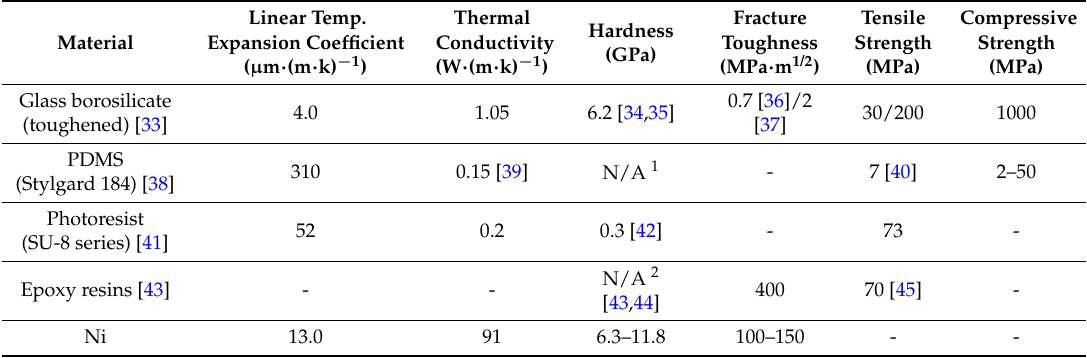
Table 2. Comparison of relevant properties for different hot embossing template